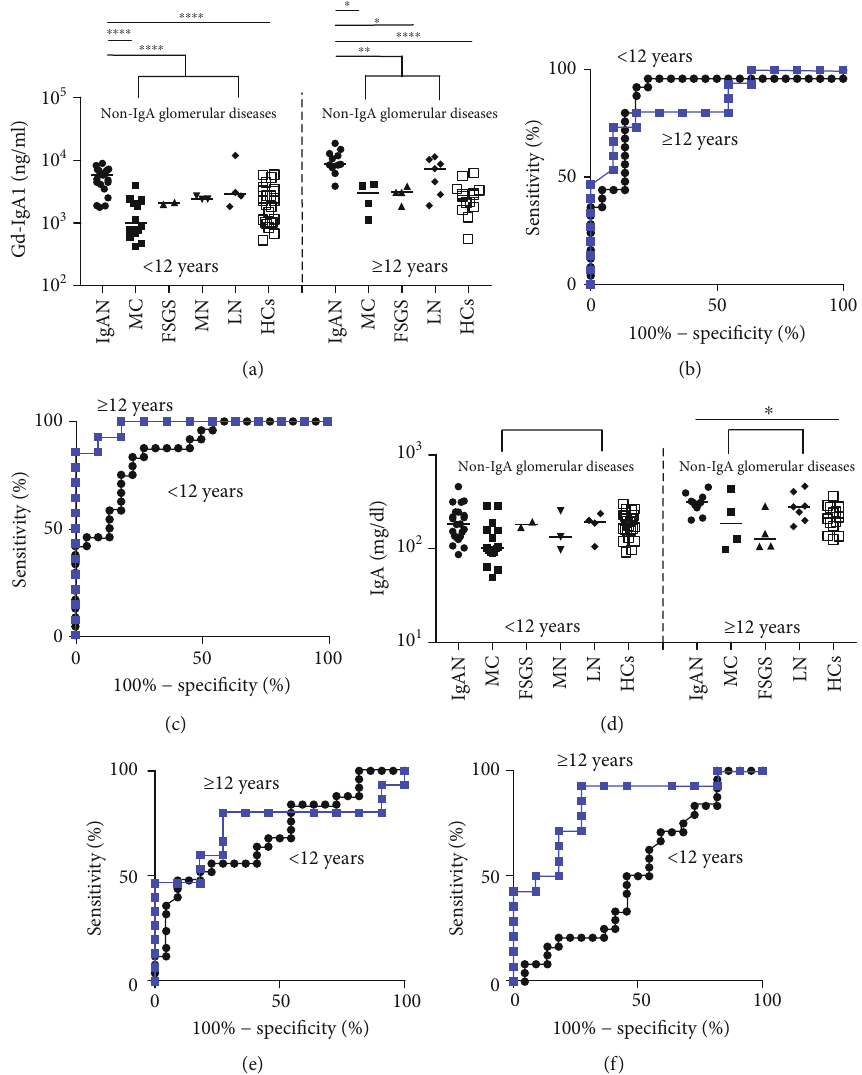
Figure 3: Serum Gd-IgA1 levels and serum total IgA levels classi fi ed by age. (a) Serum Gd-IgA1 levels classi fi ed by age. (b) The receiver operating characteristic curve analysis of serum Gd-IgA1 levels for di ff erentiating IgA nephropathy from other glomerular diseases.